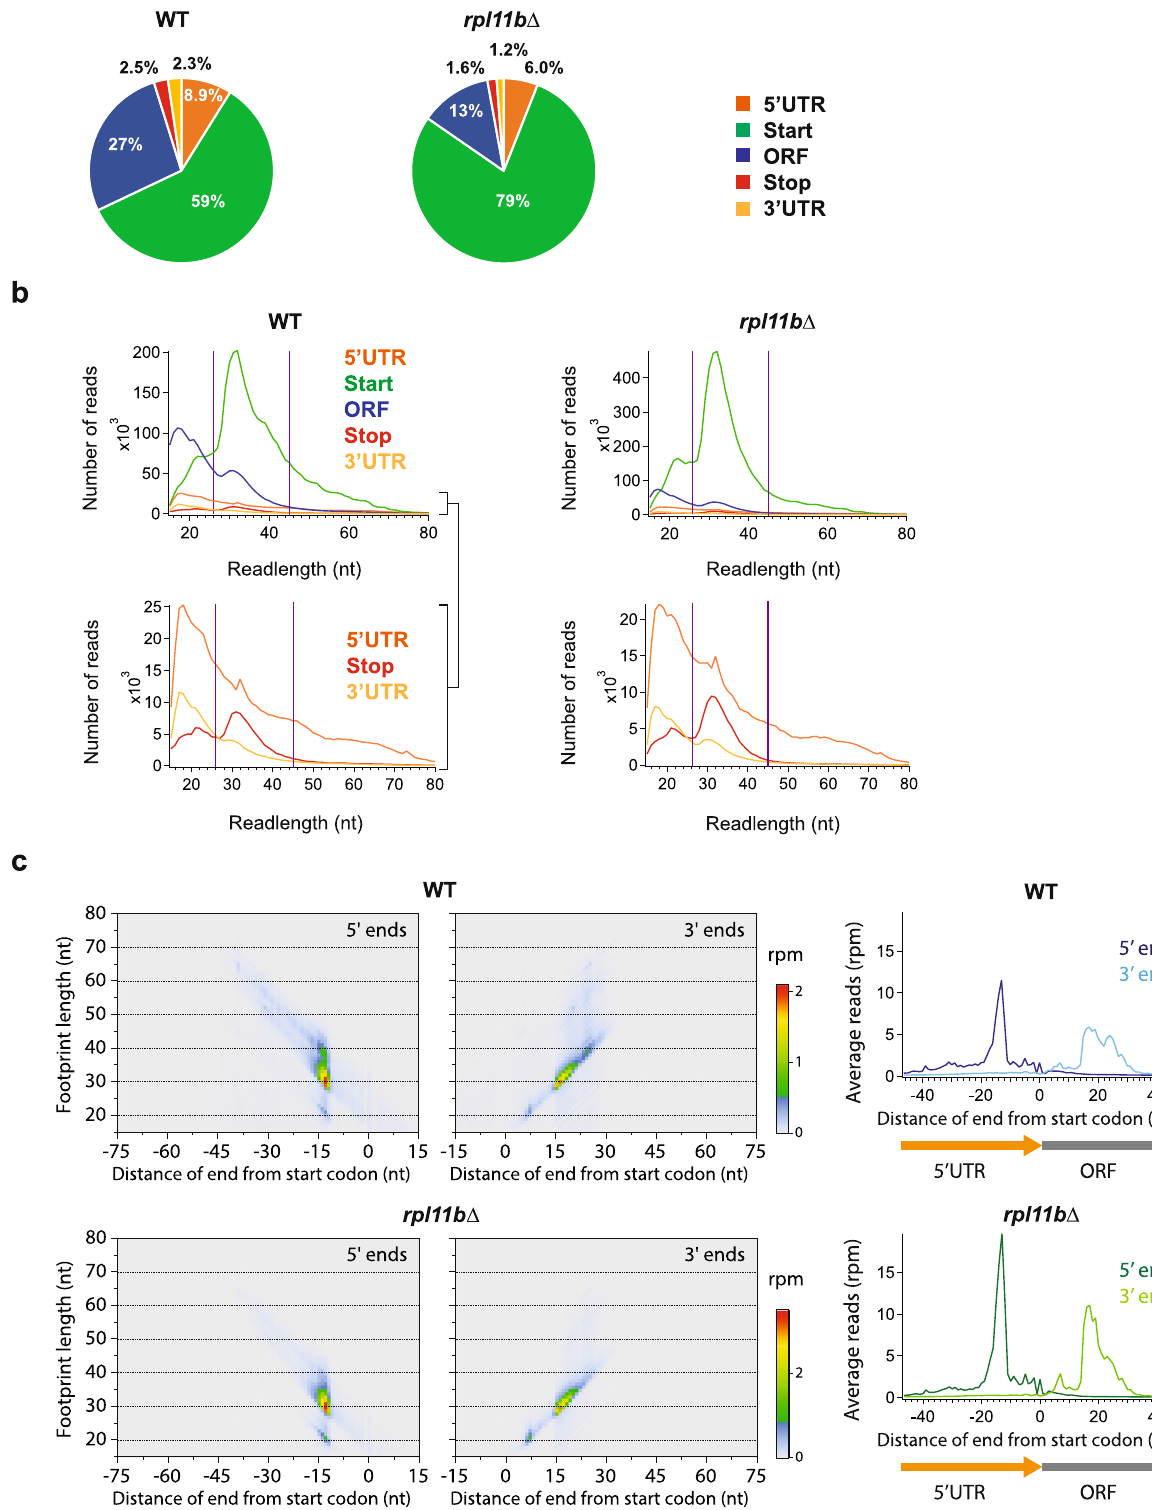
codons for each gene for both our 40S pro fi ling data and the LTM-treated 80S pro fi ling data and found a strong correlation between the two datasets (Fig. 2b; Pearson R 2 = 0.61). This is a high level of correlation given the different strain backgrounds used in the two studies (BY4741 in the current study and SK1 in Eisenberg et al. 2020 42 ) and the difference in ploidy between